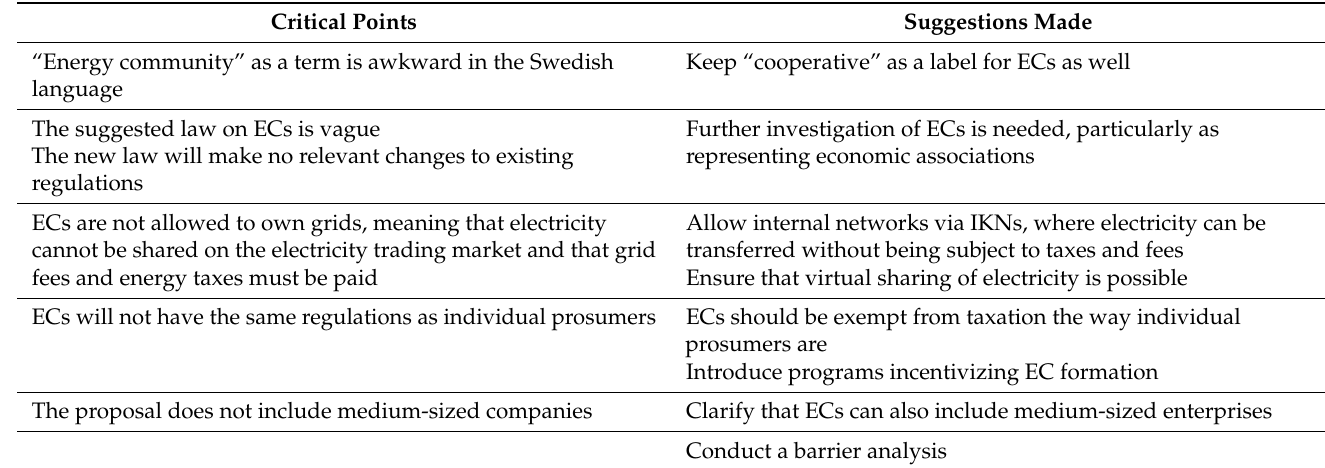
Table 4. The main critical points and suggestions made in the consultation